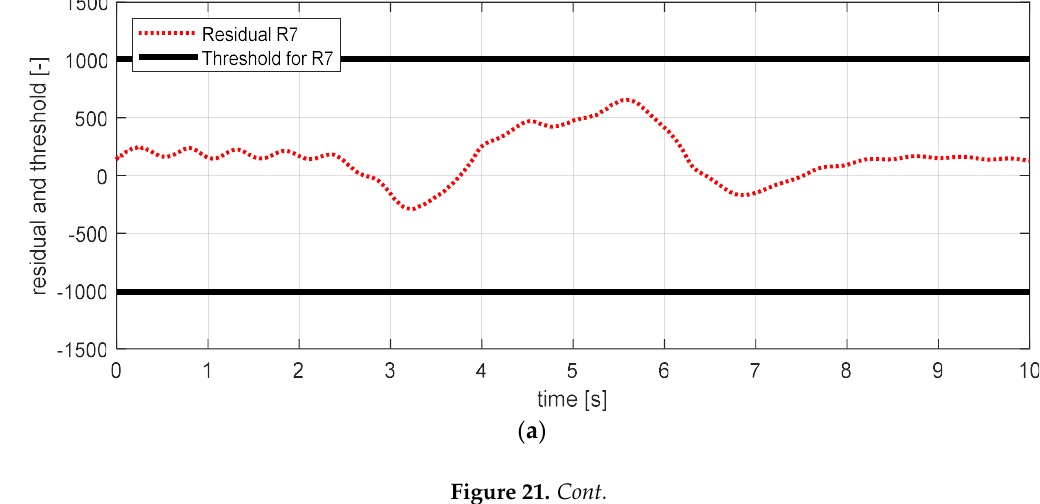
Figure 20. FDI simulation result for longitudinal acceleration sensor (fault). ( a ) Residual 7 and threshold; ( b ) residual 8 and threshold; ( c ) residual 9 and threshold; ( d ) residual 10 and threshold.